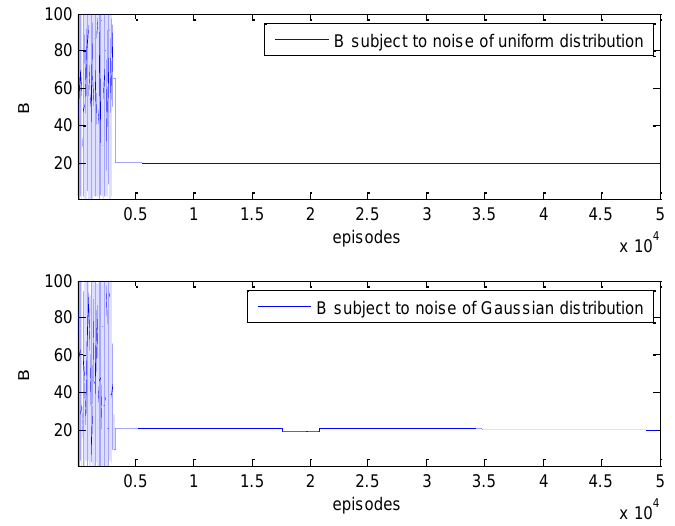
Figure 10. The episode training process with leakage of 0.02 ( B r = 20). Table 3. The results of viscous damping coefficient under leakage.